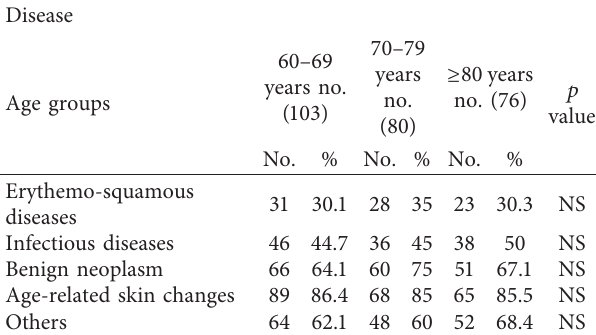
Table 3: The most prevalent skin diseases according to age groups. Disease Age